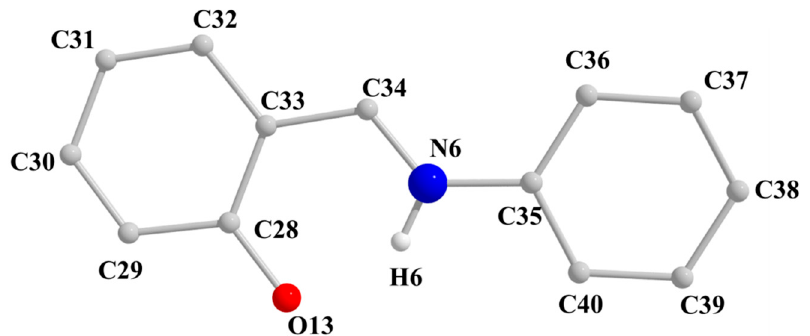
Figure 5. Fully labeled plot of the structure of the lattice free salanH molecule that is present in the crystal structure of complex 18 _Dy.